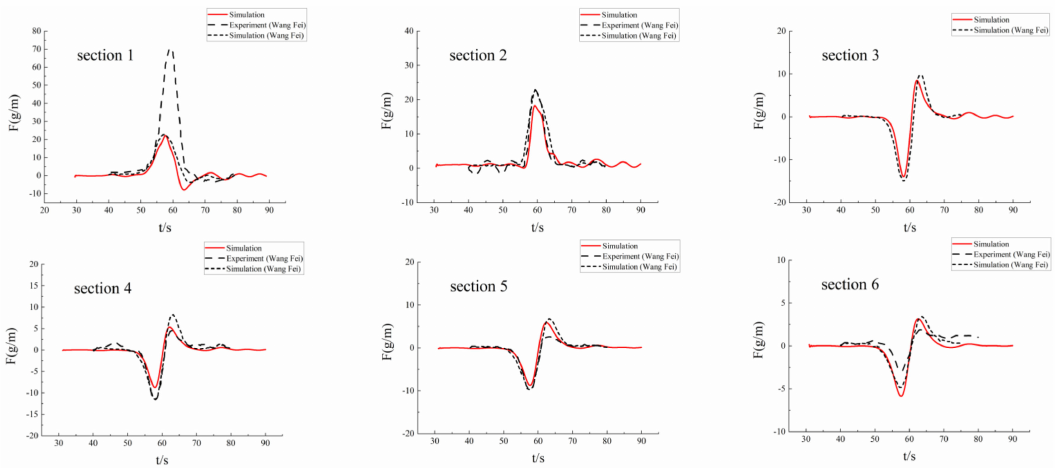
Figure 7. Comparison of horizontal resistance between experiment and numerical